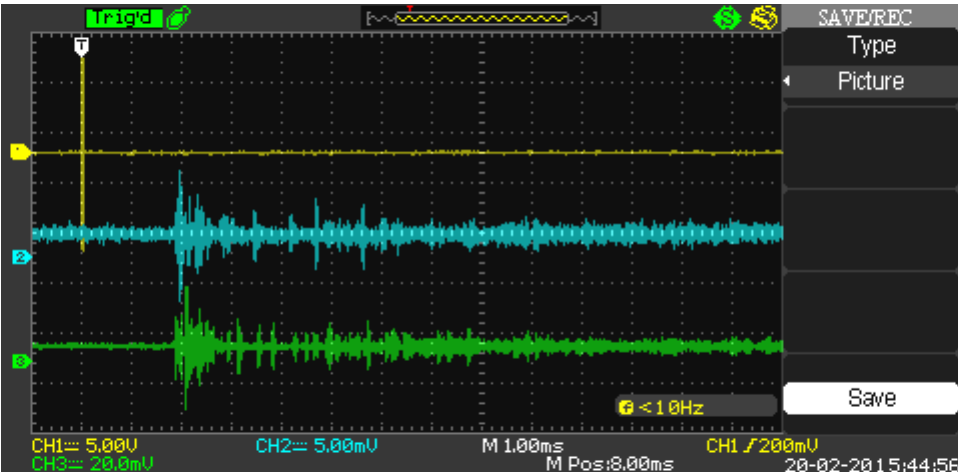
Figure 1. Example of measured signal [9]; trace 1 (yellow)—transmitted signal, trace 2 (blue), and 3 (green)—recorded signals from different receiver locations, showing different distributions of signal peaks due to the multitude of propagation paths. The difference in signal magnitudes is the result of using different receiver setups in both channels.